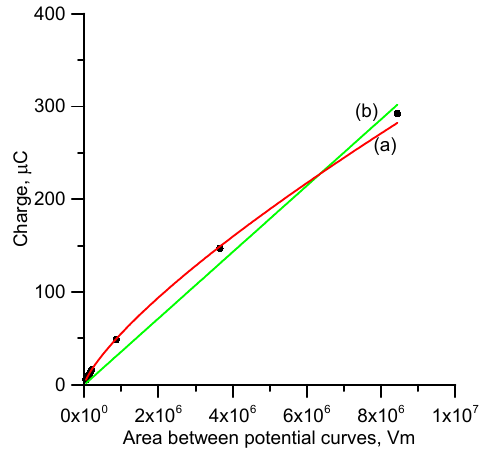
Figure 8. Best fit curves (a) exponential fit and (b) linear fit to the charge versus the area between the potential curves corresponding to a streamer branching length of 5 mm. The actual data points are also shown in the diagram.